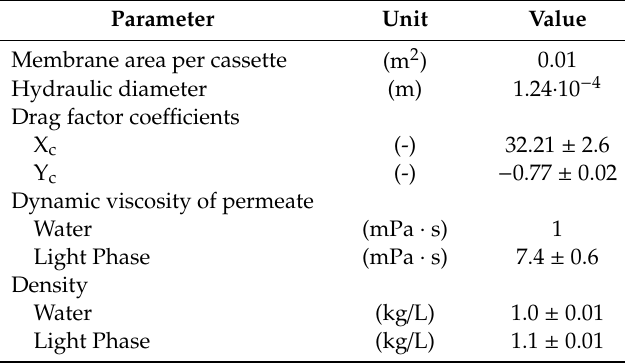
Table 4. Intrinsic membrane resistance (R M ).